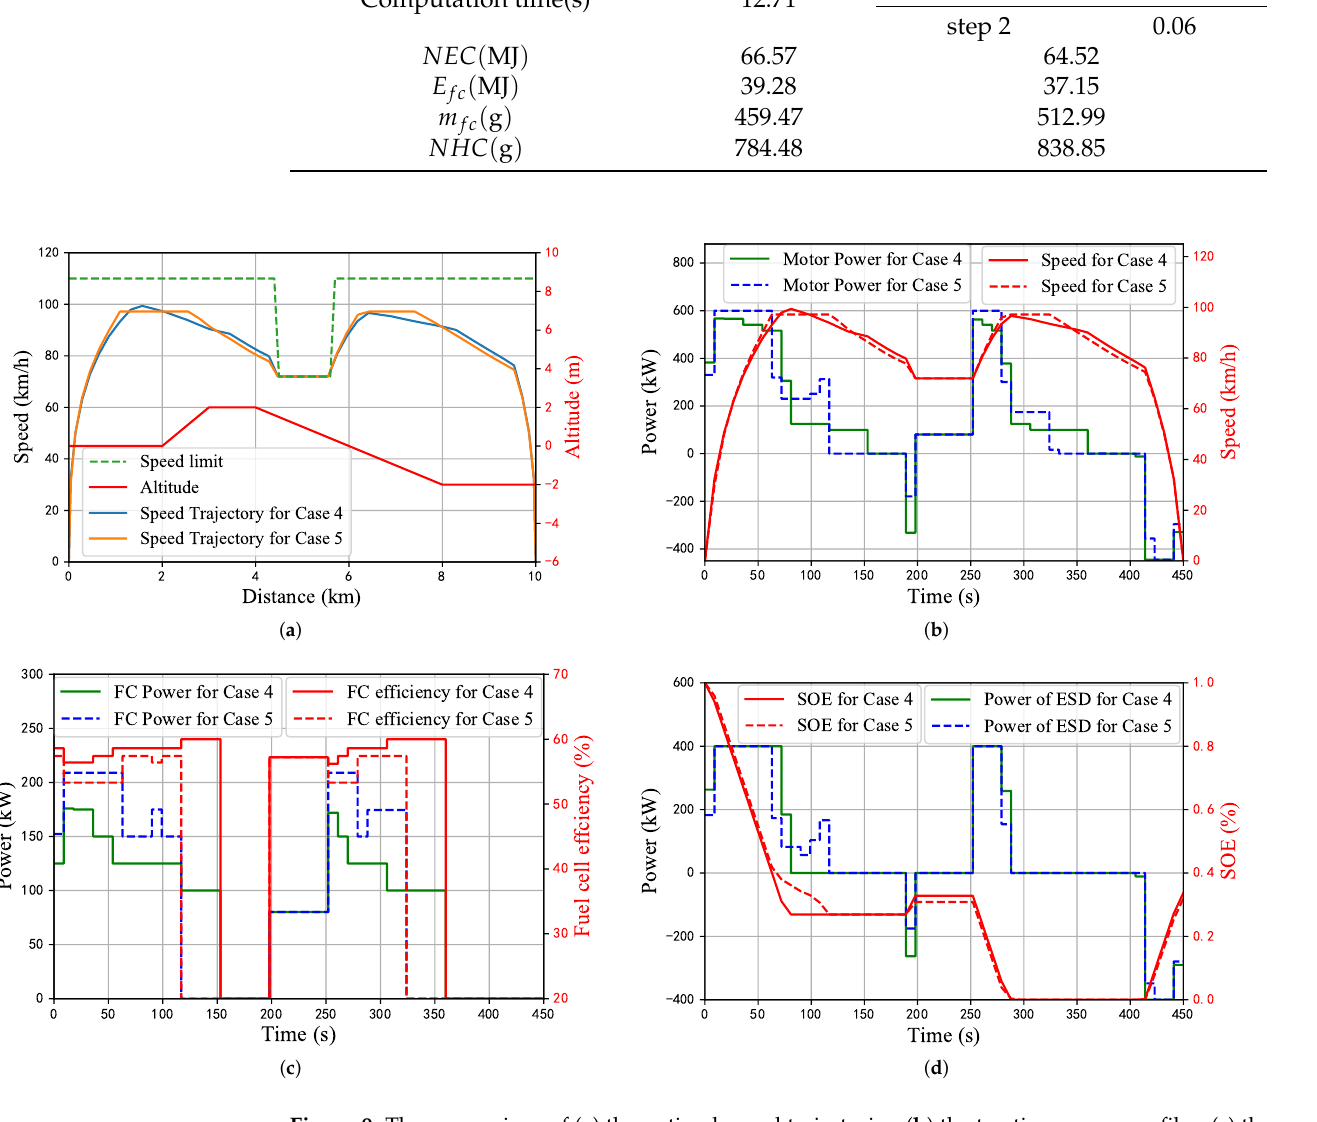
Figure 9. The comparison of ( a ) the optimal speed trajectories, ( b ) the traction power profiles, ( c ) the output power and efficiency profile of the fuel cell, and ( d ) ESD power and SOE profile in Case 4 and Case